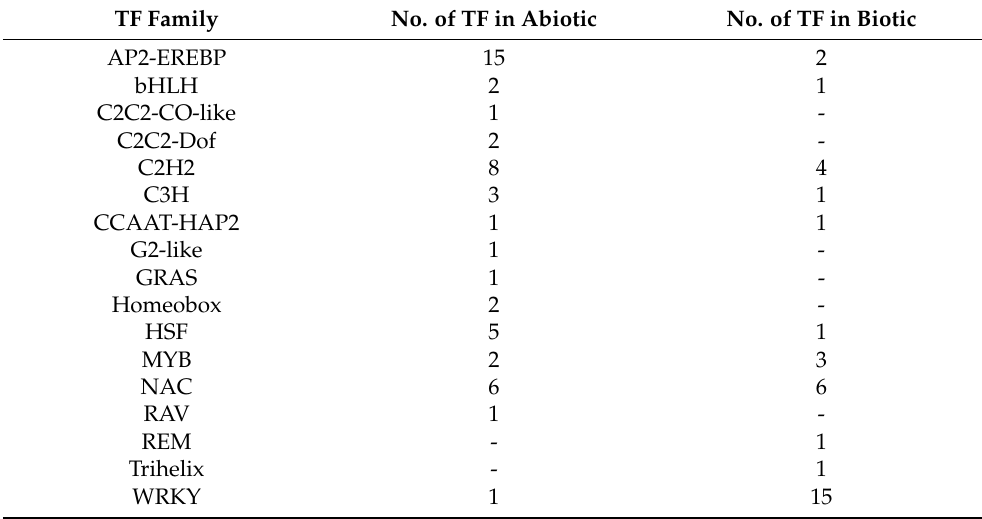
Table 2. Identified transcription factors (TF) regulated in response to biotic and abiotic stresses. TF